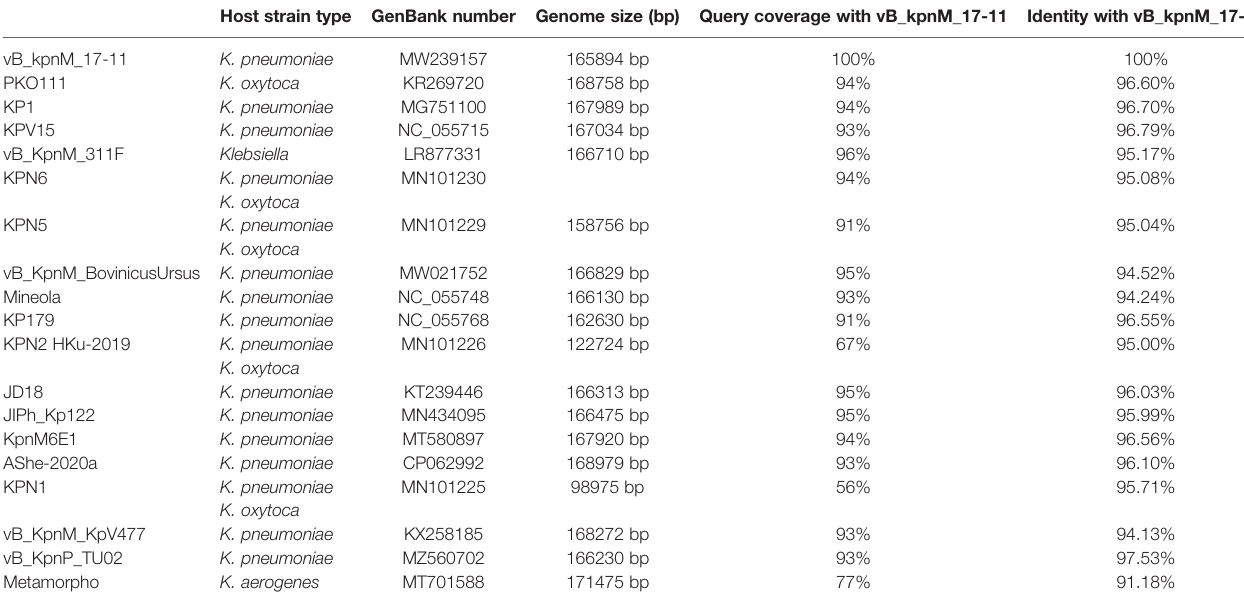
TABLE 2 | Global genome comparison of vB_kpnM_17-11 with homologous phages.